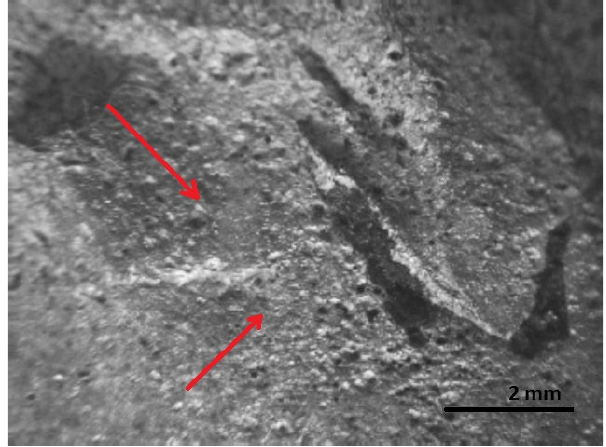
Figure 19. Fracture area: The area of the final fracture.